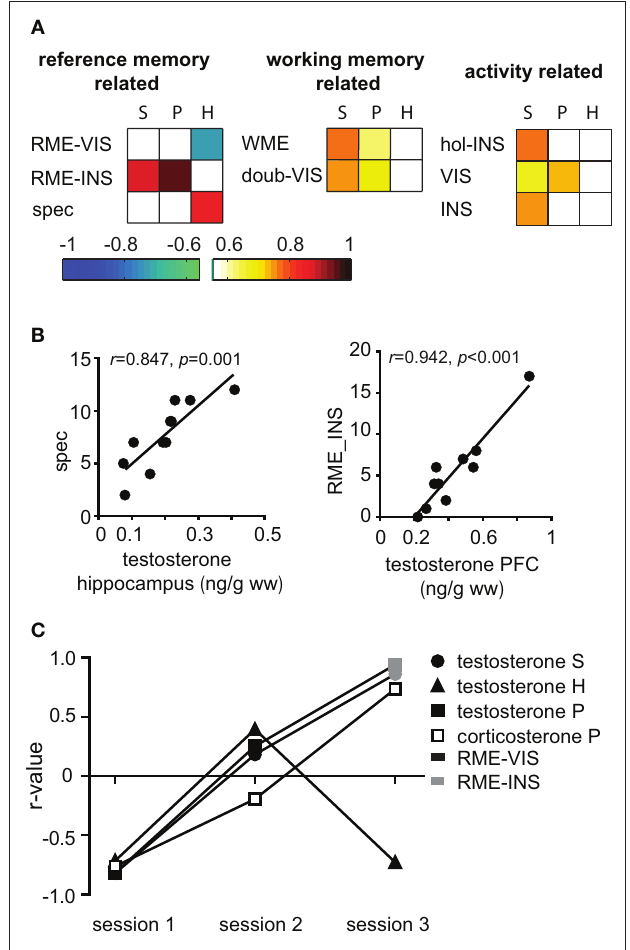
Figure 4 | role of testosterone during recall. (A) The r -value of significant correlations of testosterone with behavior in session 3 are depicted color coded for each tissue type (S, serum; P, PFC; and H, hippocampus) and parameter. spec, special cell entries; INS, inspections, VIS, visits; doub-VIS, number of double visit holes; hol-INS, number holes inspected. (B) While hippocampal testosterone correlated with the task-promoting parameter special cell entries (spec) prefrontal testosterone correlated with RME-INS. (C) There was an inversion of correlation direction with RME-INS respective RME-VIS from early to late trials for PFC and serum testosterone as well as PFC corticosterone, but not for hippocampal testosterone. (S = serum, P = PFC and H =